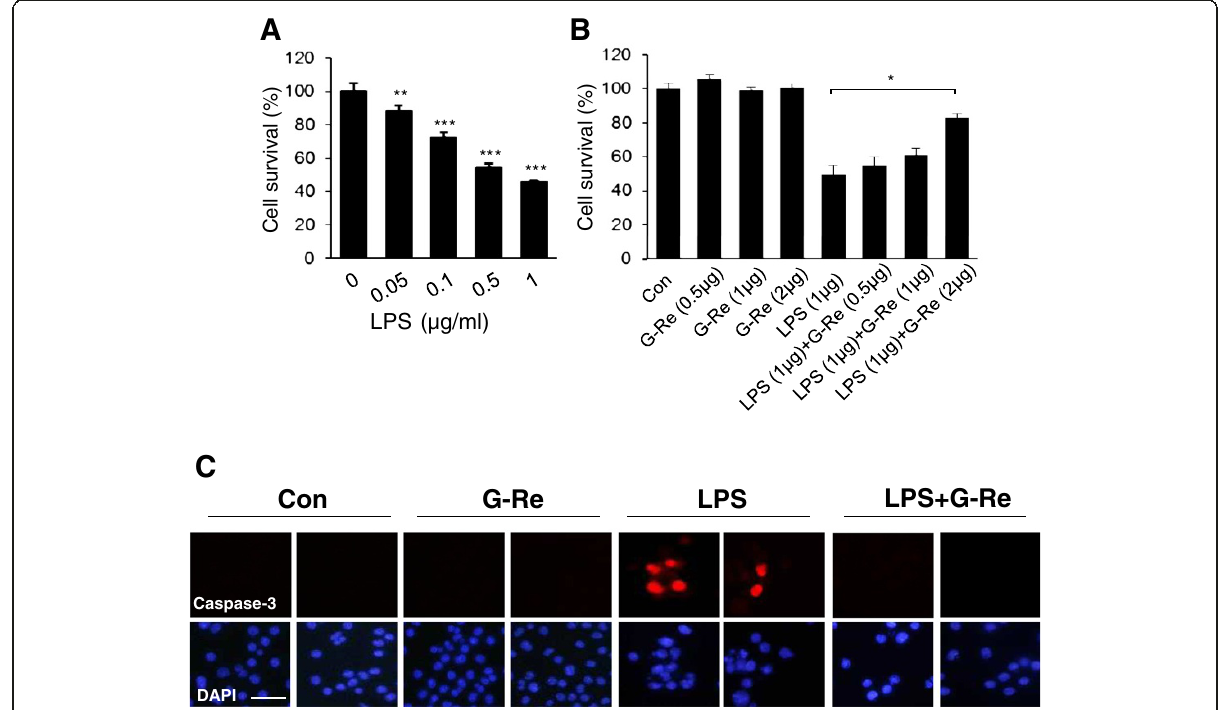
Figure 1 Effects of ginsenoside-Re on viability in LPS-induced BV2 microglial cells. ( A ) G-Re inhibits LPS-induced cell death in BV2 microglial cells. BV2 microglial cells were treated with indicated doses (0, 0.05, 0.1, 0.5 and 1 μ g/ml) of LPS for 24 h, and cell viability was measured by an MTT assay. The values shown are the mean ± S.E.M. of data obtained from three independent experiments. n=15, * p < 0.05, ** p < 0.01. ( B ) Effects of G-Re on LPS-induced microglial cell death. BV2 cells were pretreated for 24 h with 2 μ g/ml G-Re, and then stimulated with 1 μ g/ml LPS for 24 h in the presence or absence of G-Re. The rates of cell survival were measured by a MTT assay at 570 nm. The values shown are the mean ± S.E.M. of data obtained from three independent experiments. ( C ) BV2 cells were pretreated with 2 μ g/ml G-Re for 24 h and then stimulated to 1 μ g/ml LPS for 24 h in the presence or absence of 2 μ g/ml G-Re. Cells were visualized using immunofluorescence microscopy with antibodies against active caspase-3. The values shown are the mean ± S.E.M. of data obtained from three independent experiments. (bars: 50 μ m.) * p <